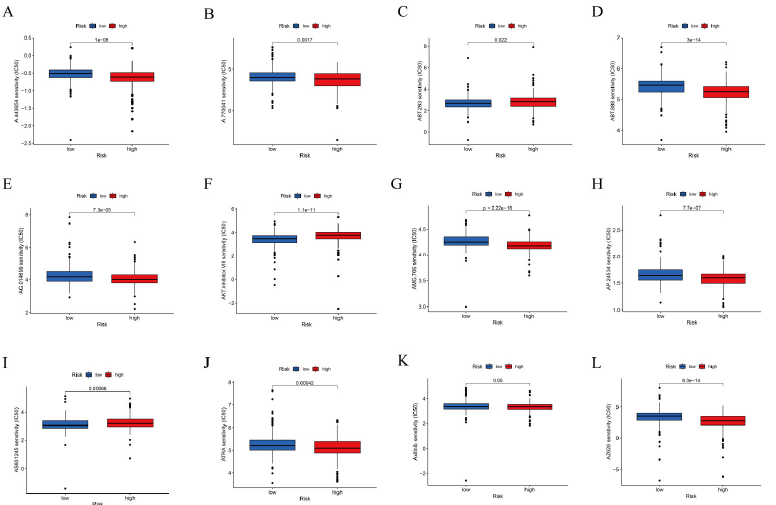
Figure 11. IC50 and therapeutic response analysis. The low-risk group is shown in blue on the abscissa, and the high-risk group is shown in red. The IC50 value of drug target sensitivity is shown on the ordinate. ( A ) A.443654. ( B ) A.770041. ( C ) ABT.263. ( D ) ABT.888. ( E ) AG.014699. ( F ) AKT inhibitor VIII. ( G ) AMG.706. ( H ) AP.24534. ( I ) AS601245. ( J ) ATRA. ( K ) Axitinib. ( L ) AZ628. The detailed p values are shown in Figure 11.